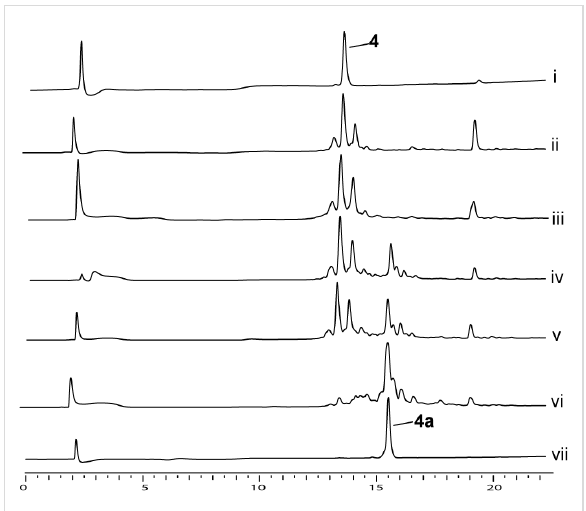
Figure 3: Sulfonylation optimization study. HPLC trace overlay that shows the sulfonylation of motif 4 to yield sulfonylamide 4a under dif- ferent reaction conditions. i) purified 4 . ii) crude 4 . vii) purified 4a . HPLC trace of crude reaction mixture after 2 h treatment with o -NBS-